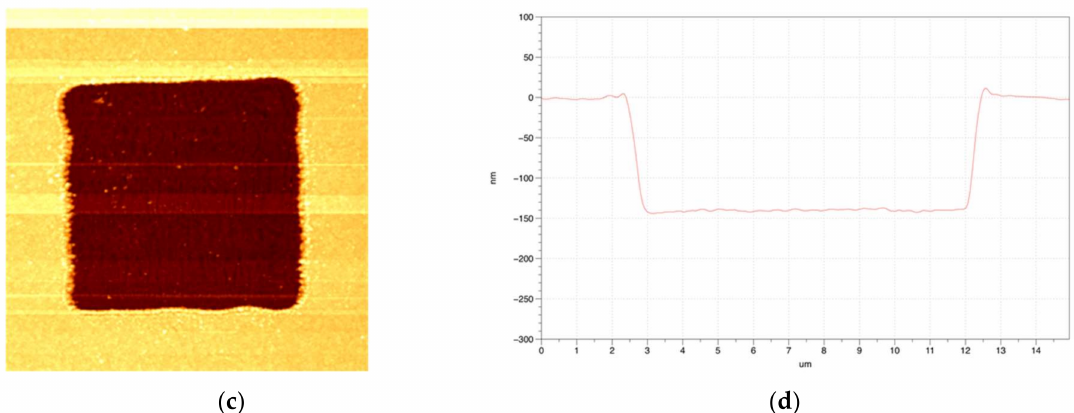
Figure 5. Images of the atomic force microscope (AFM) two-dimensional (2D) morphology data ( a ) with the Gaussian beam profile, and ( c ) with the quasi-flat top beam profile. The cross-section of the ablated area obtained by AFM after femtosecond laser irradiation ( b ) with the Gaussian beam ( d ) with the quasi-flat top